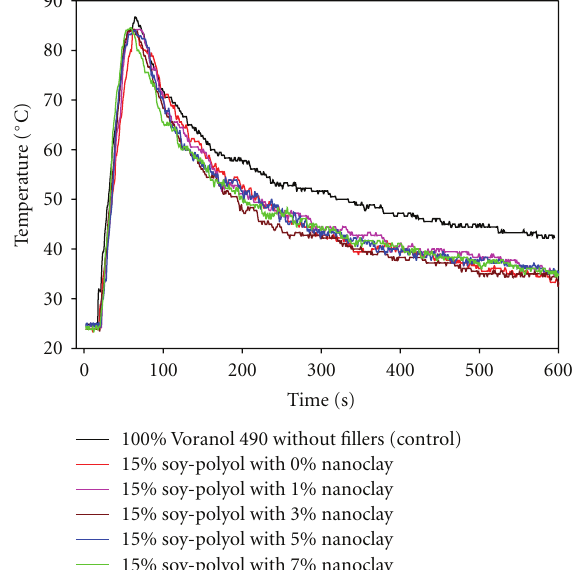
Figure 7: Foaming temperature of control and SBO PUF made from 15% soybean oil-based polyol and modified with nanoclay.